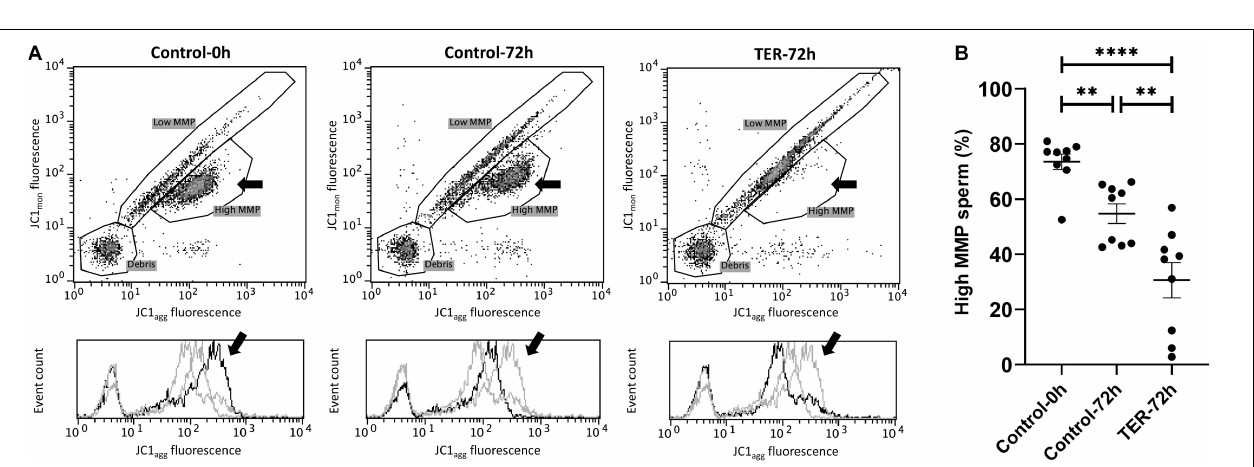
FIGURE 5 | Computer-assisted sperm analysis (CASA) of pig semen samples. Mean, standard error of the mean (SEM), and sample distribution of the percentage of (A) total motile sperm, (B) progressively motile sperm, and (C) average path velocity sperm (VAP; µ m/s) in all treatments. Control-0h, semen samples at 0 h of storage; Control-72h, vehicle control (dimethyl sulfoxide; DMSO) semen samples at 72 h of storage at 17 ◦ C; TER-72h, semen samples treated with 100 µ M ezatiostat (TER) for 72 h of storage at 17 ◦ C. Sample size ( n = 9). * p ≤ 0.05; ** p ≤ 0.01; **** p ≤ 0.0001.